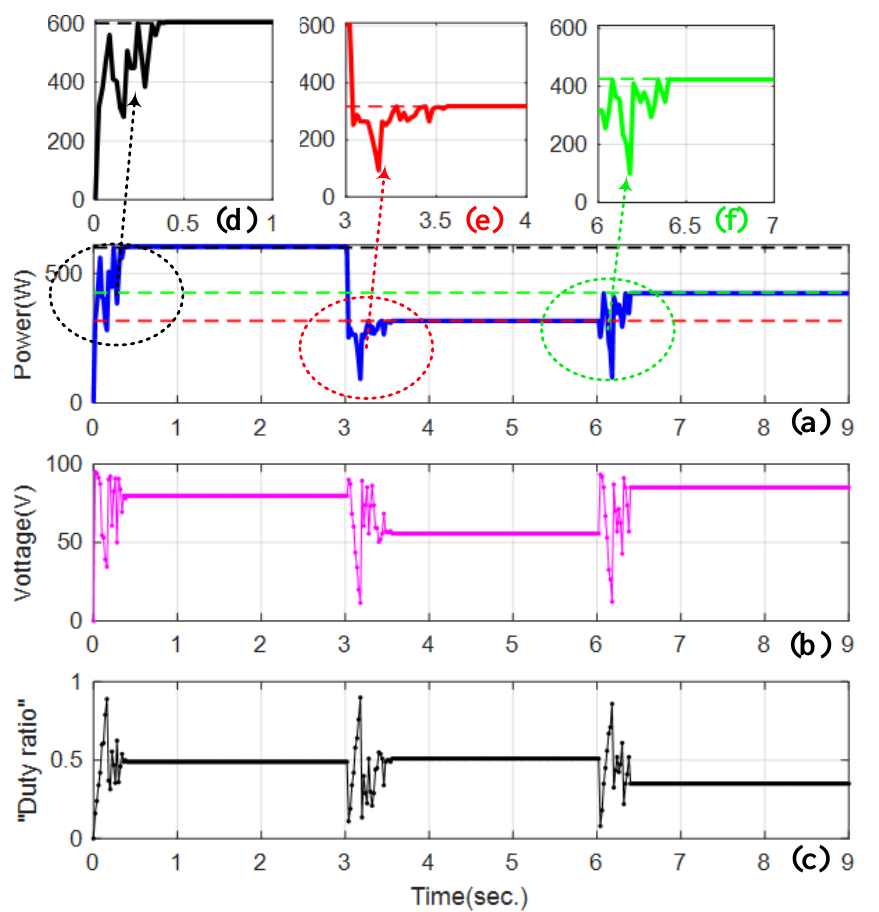
Figure 9. Results of the proposed HRA method for three serial panels. ( a ) PV power, ( b ) PV voltage, ( c ) duty ratio, and ( d – f ) transient trajectories for situations 1–3, respectively. (Black –, red –, green –: global maximum values of situations 1 – 3).